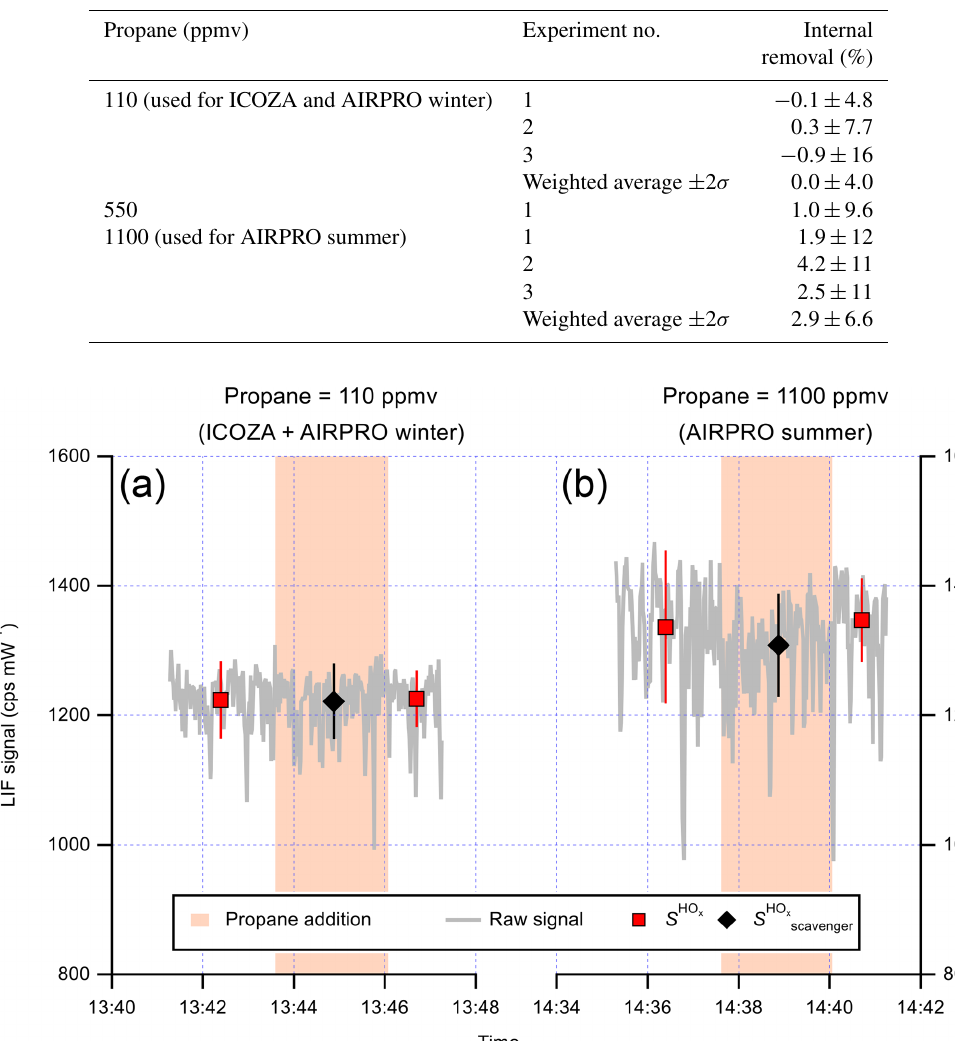
Table 2. Internal removal of OH (%, ± 2 σ ) as a function of propane mixing ratio in the IPI flow tube, determined as shown in Fig. 6 (see text for details).